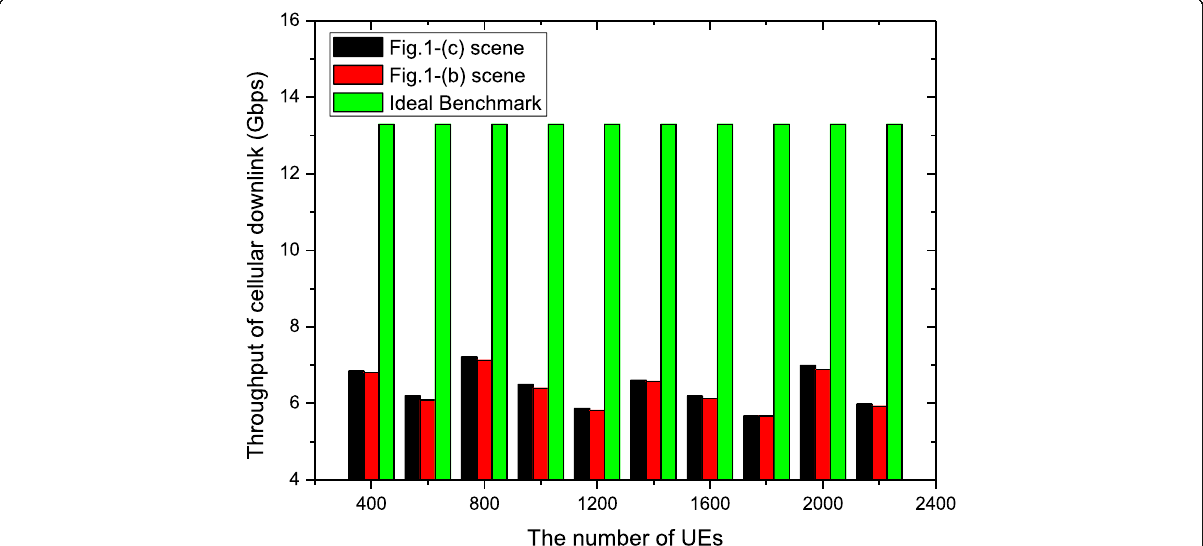
Fig. 19 Throughput for the DTO-MROD scheme and ideal benchmark under the different scenes in Fig.